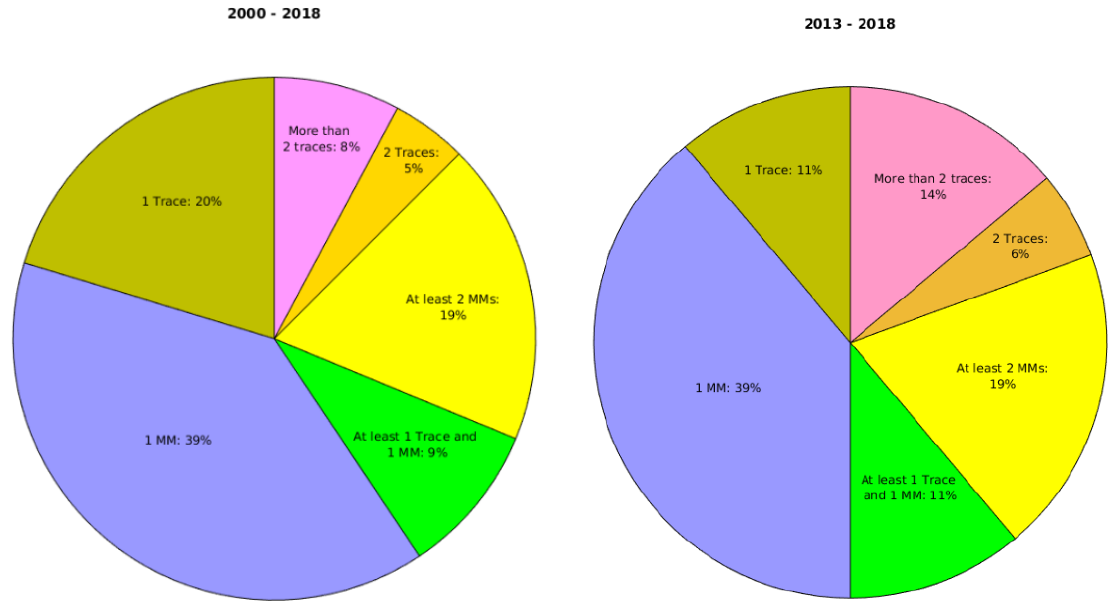
Figure 7. Used mobility models in the here explored studies. There is a slight trend towards using more than 2 traces or at least 1 trace and 1 mobility